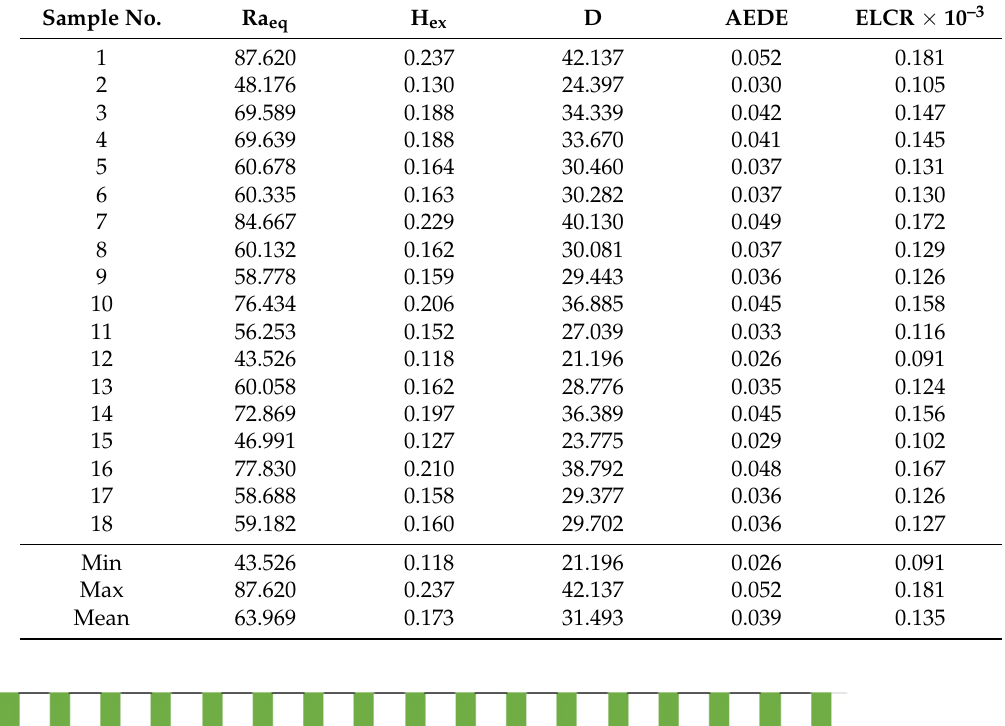
Table 4. Calculated radiological parameters in Jeddah Coast sediment.